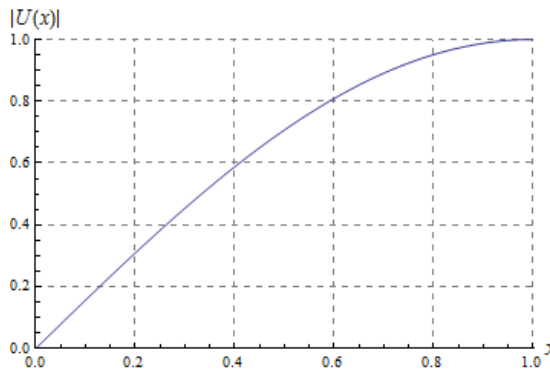
Fig. 2. Voltage U distribution by coil